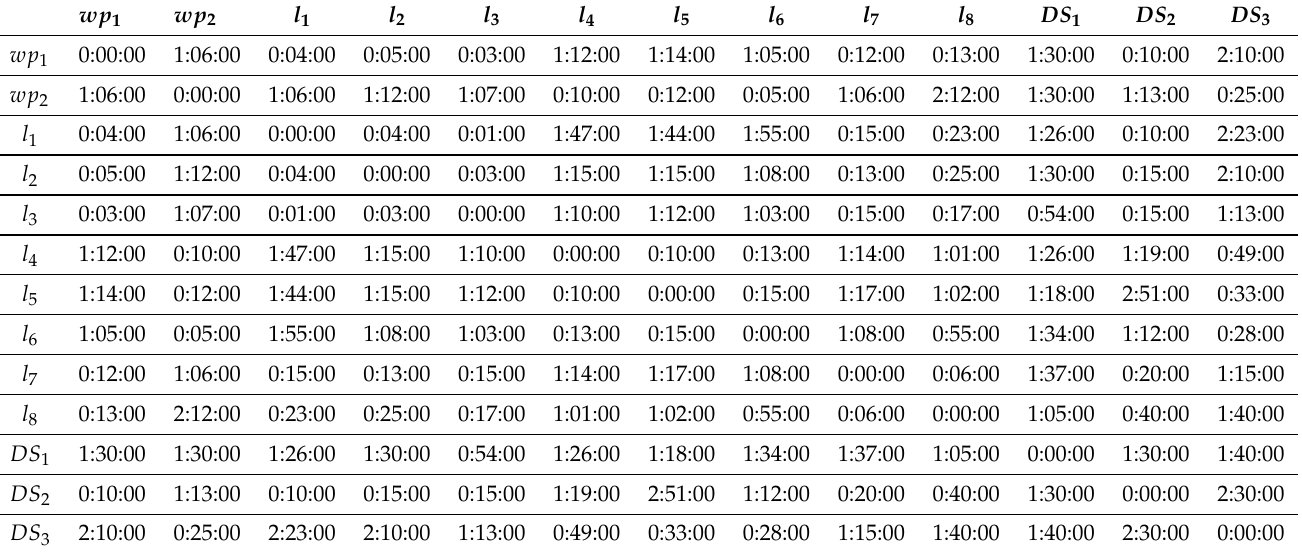
Table A1. Time distance matrix based on bike displacements. A cell c ij indicates the time required to move from location i